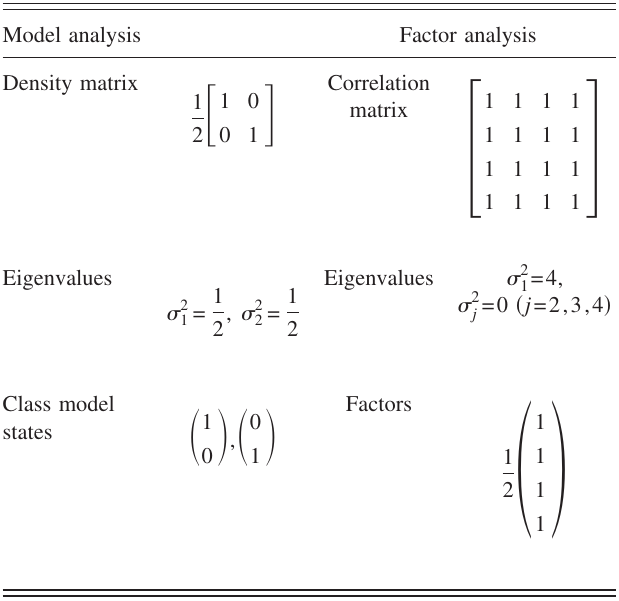
MODEL ANALYSIS: REPRESENTING AND ASSESSING